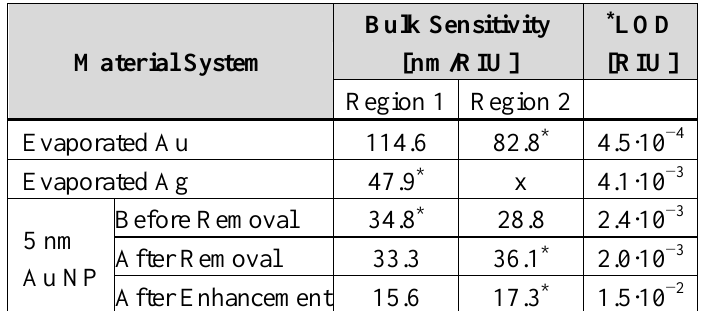
refer to the measured nanowire region on a chip. Please refer again to Table 1 for the summarized wire dimensions. An ‘x’ is displayed in regions where measurements were either not yet performed or not